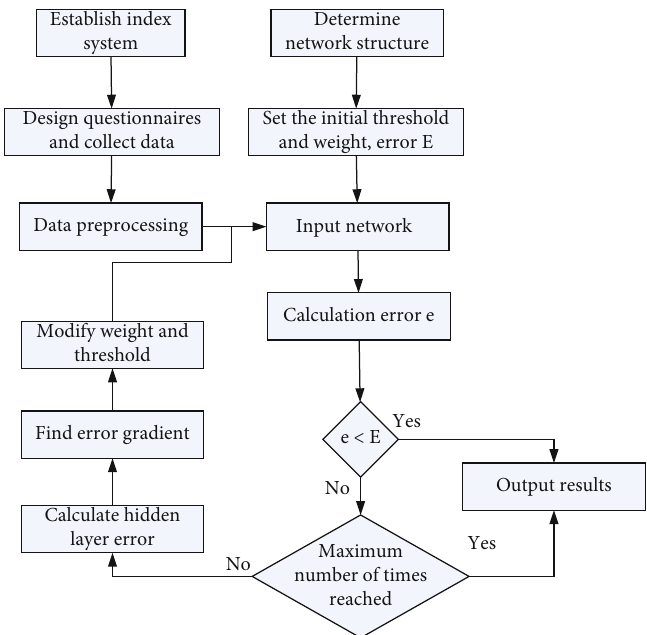
Figure 2: Teaching mode of audio-visual-oral theory of college English based on BP neural